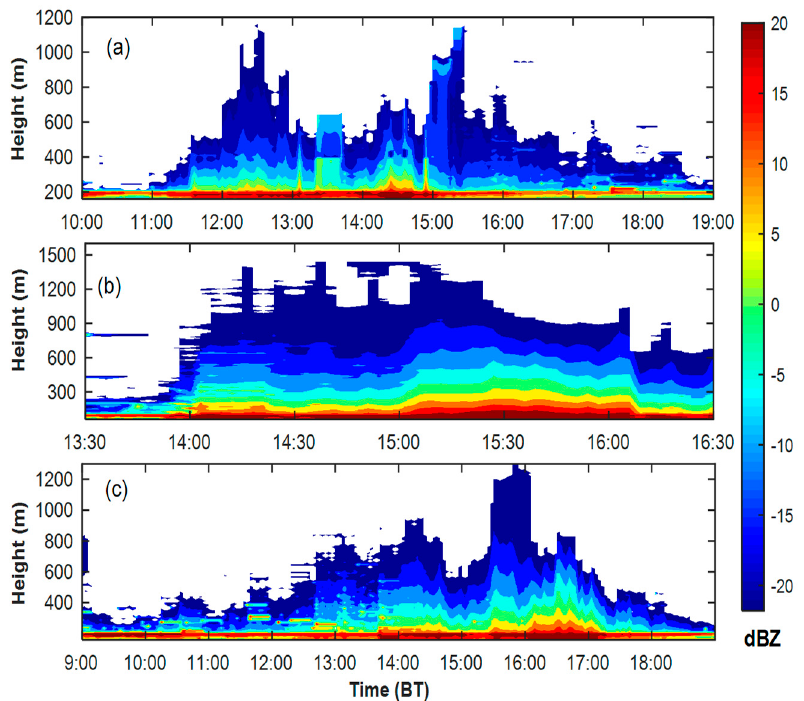
Figure 7. The temporal and altitudinal distribution of the reflectivity factor. ( a ) 7 May. ( b ) 20 May. ( c ) 24 May. Table 4. Distribution features of reflectivity factors at di ff erent heights during the dust storm